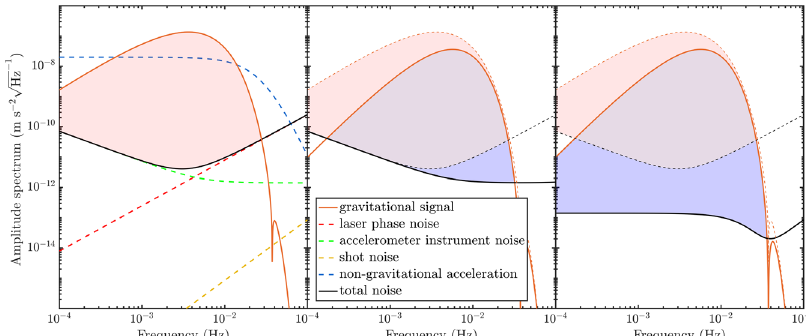
Fig. 6 Noise spectrum analysis of proposed satellite geodesy missions. a Signal and noise spectra for a GRACE-FO-like, two-satellite mission, formation α O . The gravitational signal corresponds to a 1 × 10 13 kg point mass, satellite separation of L = 200 km and satellite orbital height of ffiffiffiffiffiffi p 2 (cid:3) 1 Hz h = 500 km (Eq. (1)), accelerometer instrument noise corresponds to a 0 ¼ 1 ´ 10 (cid:3) 12 ms (cid:3) 2 (Eq. (2)), laser phase noise corresponds to x T = 1 × 10 − 15 (Eq. (5)), the quantum noise level is calculated by considering the diffraction limits set by a 25 cm receiving aperture radius and 25 mW of initial optical power (Eq. (6)) and the non-gravitational accelerations are those from Eq. (20). The region highlighted in red corresponds to frequencies where the signal is above the noise fl oor, i.e., the region which contributes most to enhancing the signal-to-noise mission, with three satellites and TDI being employed. The gravitational signal after ratio. b Signal and total noise spectrum for a formation α T 3 mission. The TDI is given by Eq. (10). The dashed orange and black lines correspond to the gravitational signal and total noise from the α O 2 mission, the region highlighted in blue shows the new region highlighted in red corresponds to regions which can only be accessed by the α O 2 region which can be accessed by the α T mission and the mauve region in between is accessible for both missions. As TDI is a non-destructive 3 mission is still accessible. The increase in the size of the shaded region highlights the measurement the region where the SNR> 1 for the α O 2 with TDI bene fi t of TDI in this instance. Satellite positions are assumed to be known to within 5 mm. The spectra corresponding to scheme α T ffiffiffi p 3 2 sin ð π f = f c Þj jÞ so that quantum noise and accelerometer noise are unaffected by TDI. c Signal and total noise spectrum are rescaled by 1 = ð 2 for a formation α T style mission, with six different mass satellites and TDI being employed. Again the blue region corresponds to the bene fi t 6 ; DM mission. Each A-B satellite pair is assumed to fl y within 1 m of each other. The of this scheme, the region which cannot be accessed by the α O ffiffiffi p 2 2 sin ð π f = f c Þj jÞ . For all of the plots the gravitational signals have units spectra corresponding to scheme α T with TDI are rescaled by 1 = ð 2 6 ; DM ms − 2 Hz − 1